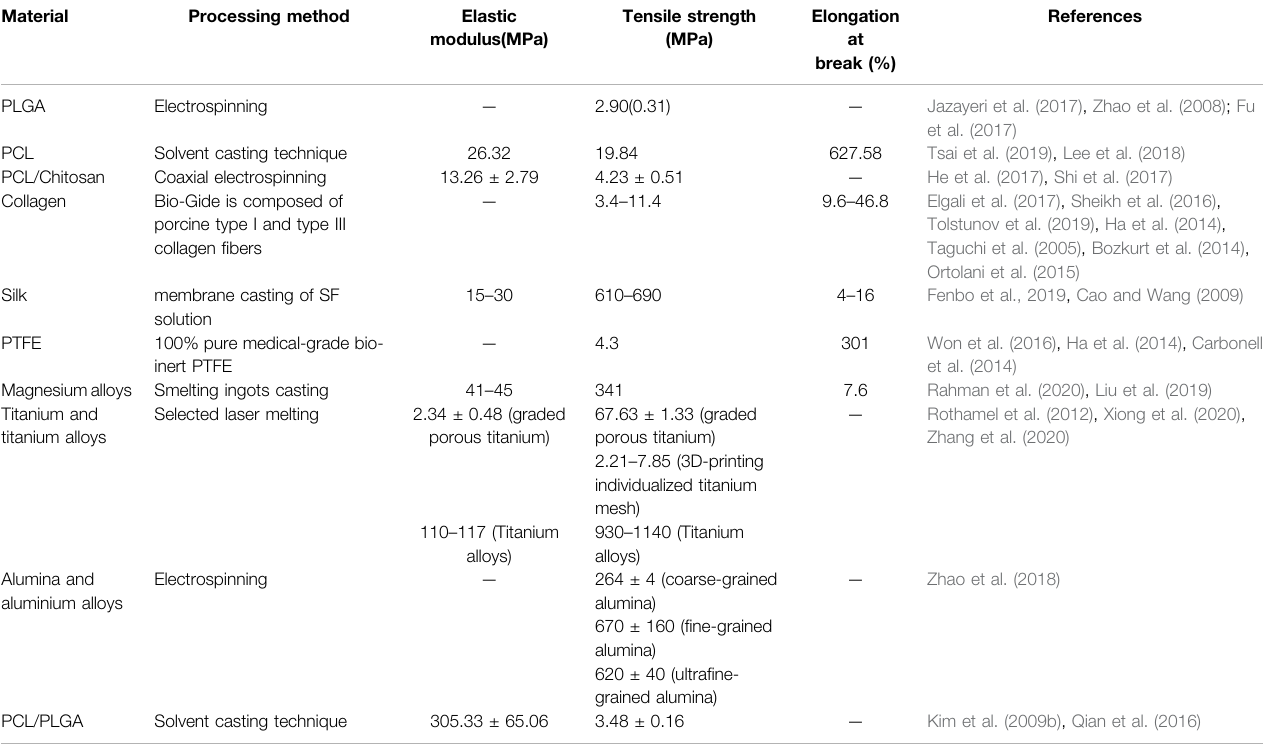
TABLE 2 | Mechanical properties of barrier